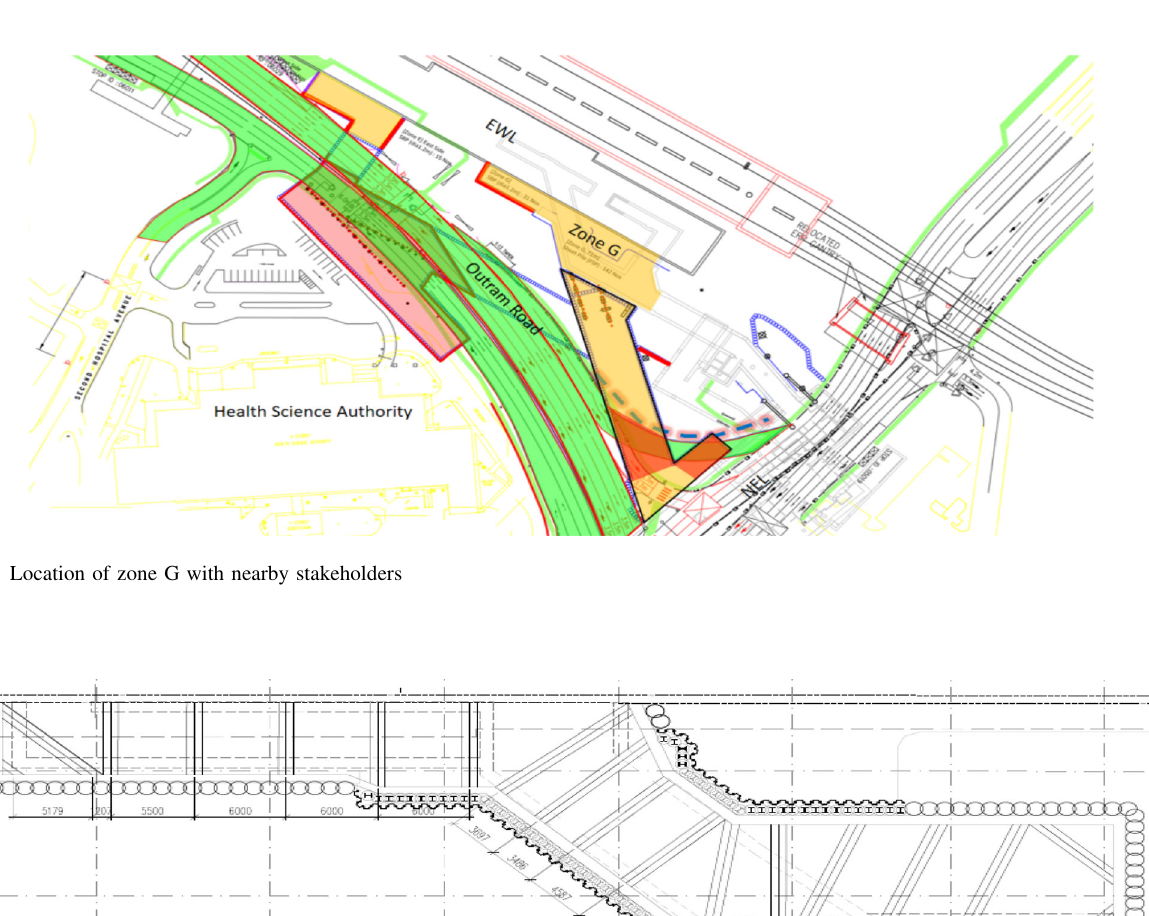
Fig. 3 Soil profile and core box result at zone G